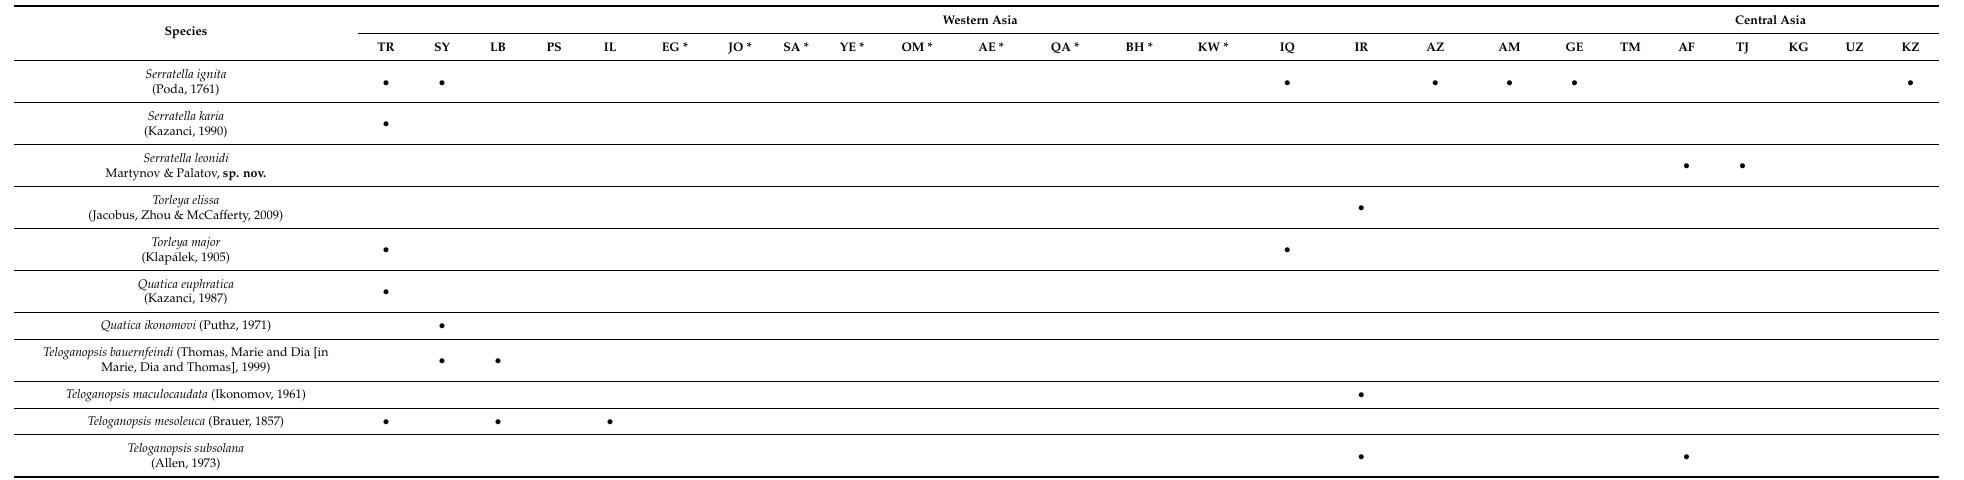
Table 3. Distribution of Hyrtanellini Allen, 1980 in Western and Central